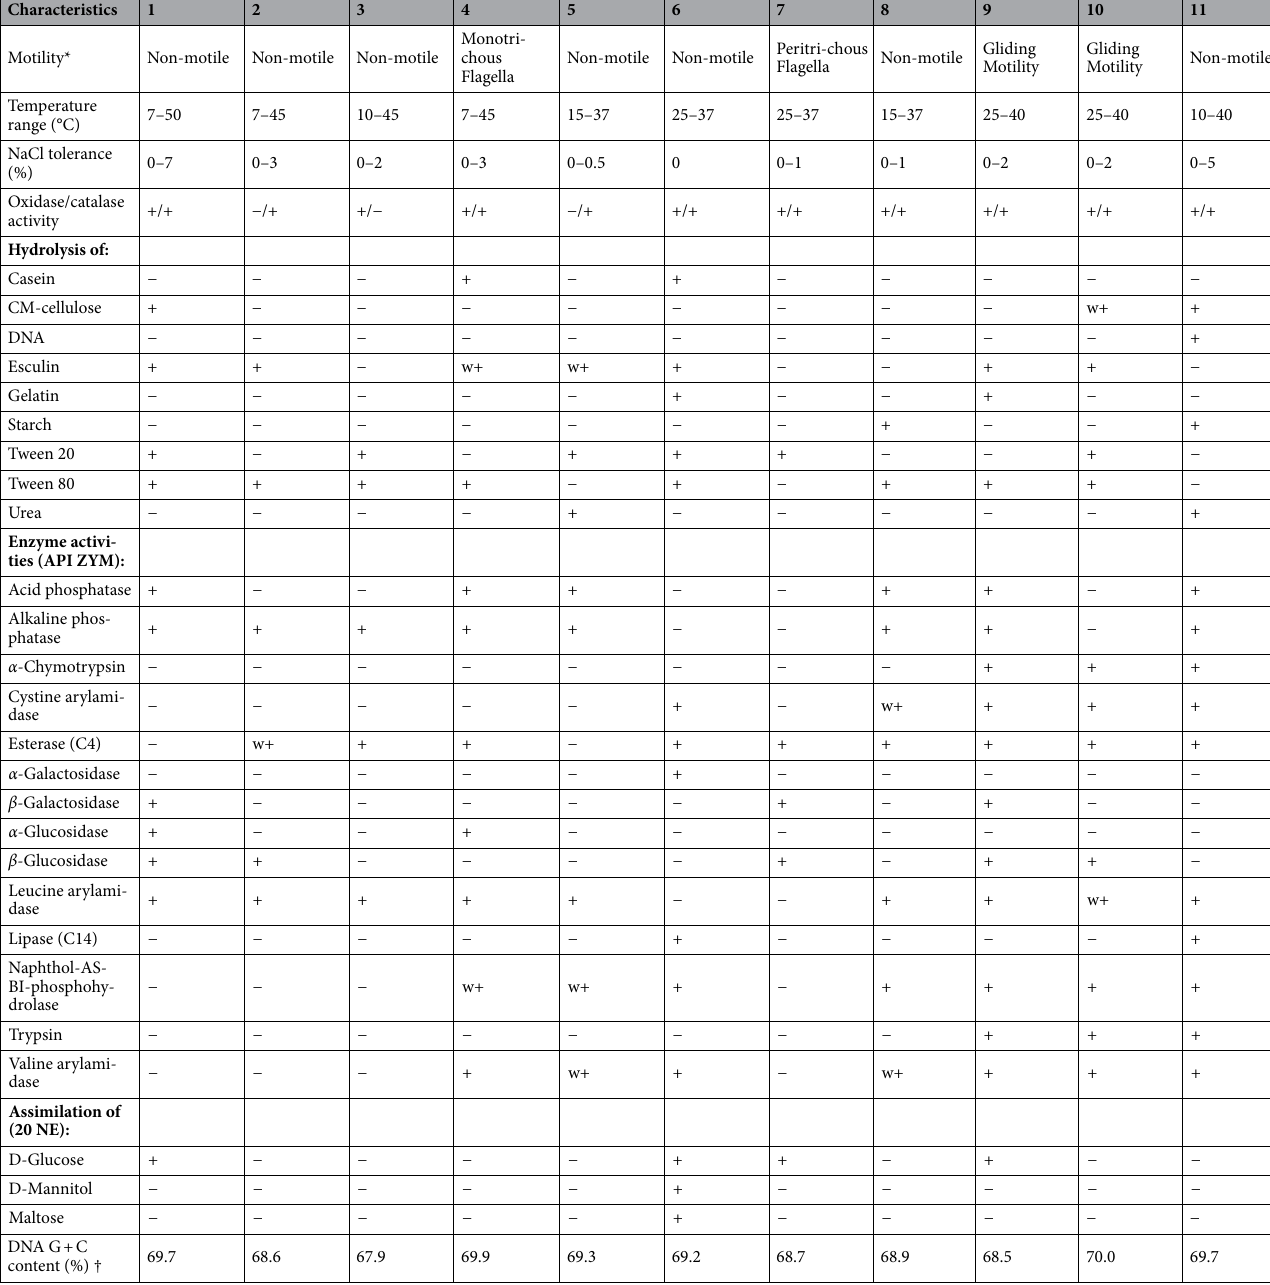
Table 1. Characteristics differentiating strains USB13 T , AW1 T , GTP1 T , and HM2 T from closely related strains of the genus Ramlibacter . * Data from original literature 1,3–5,7,8 . † From NCBI Genome Database (https:// www. ncbi. nlm. nih. gov/